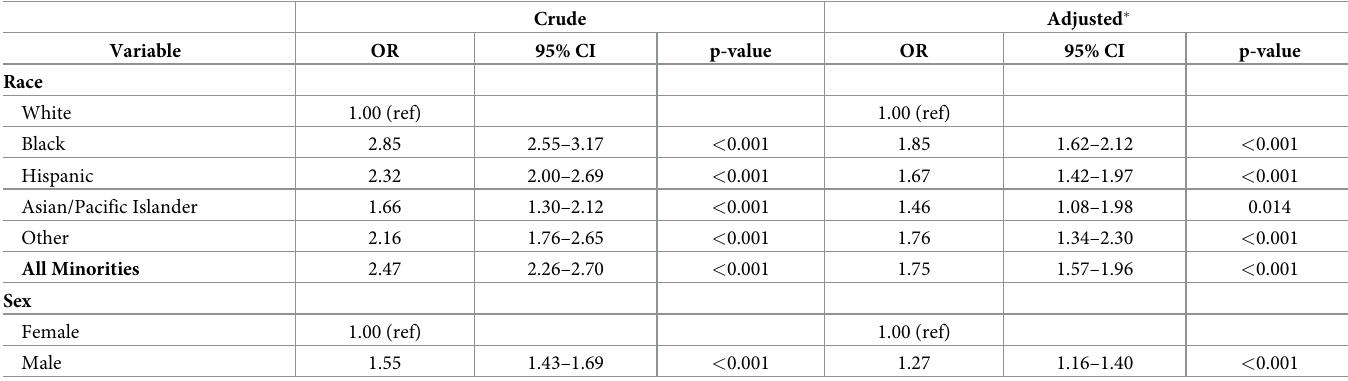
Table). Racial differences in non-beneficial PEG tubes after stroke vary by sex In the entire study population comprised of patients with in-hospital mortality, discharge to hospice, or undergoing palliative/withdrawal of care, non-beneficial PEG tubes after any stroke were most common among ethnic/racial minority men (11.9%), while only 3.8% of white women received a PEG tube (Table 3). Similarly, the adjusted odds of PEG were highest Table 3). Differences by race were most pronounced among women: ethnic/racial minority Table 2. Race and sex as determinants of non-beneficial PEG tubes after